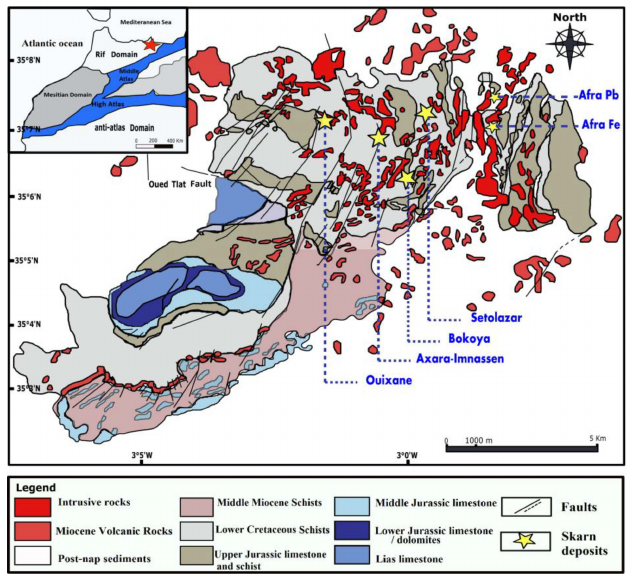
Figure 2. Location of the main Ouixane iron deposits from the mining district on the geological map, modified after [8,14].